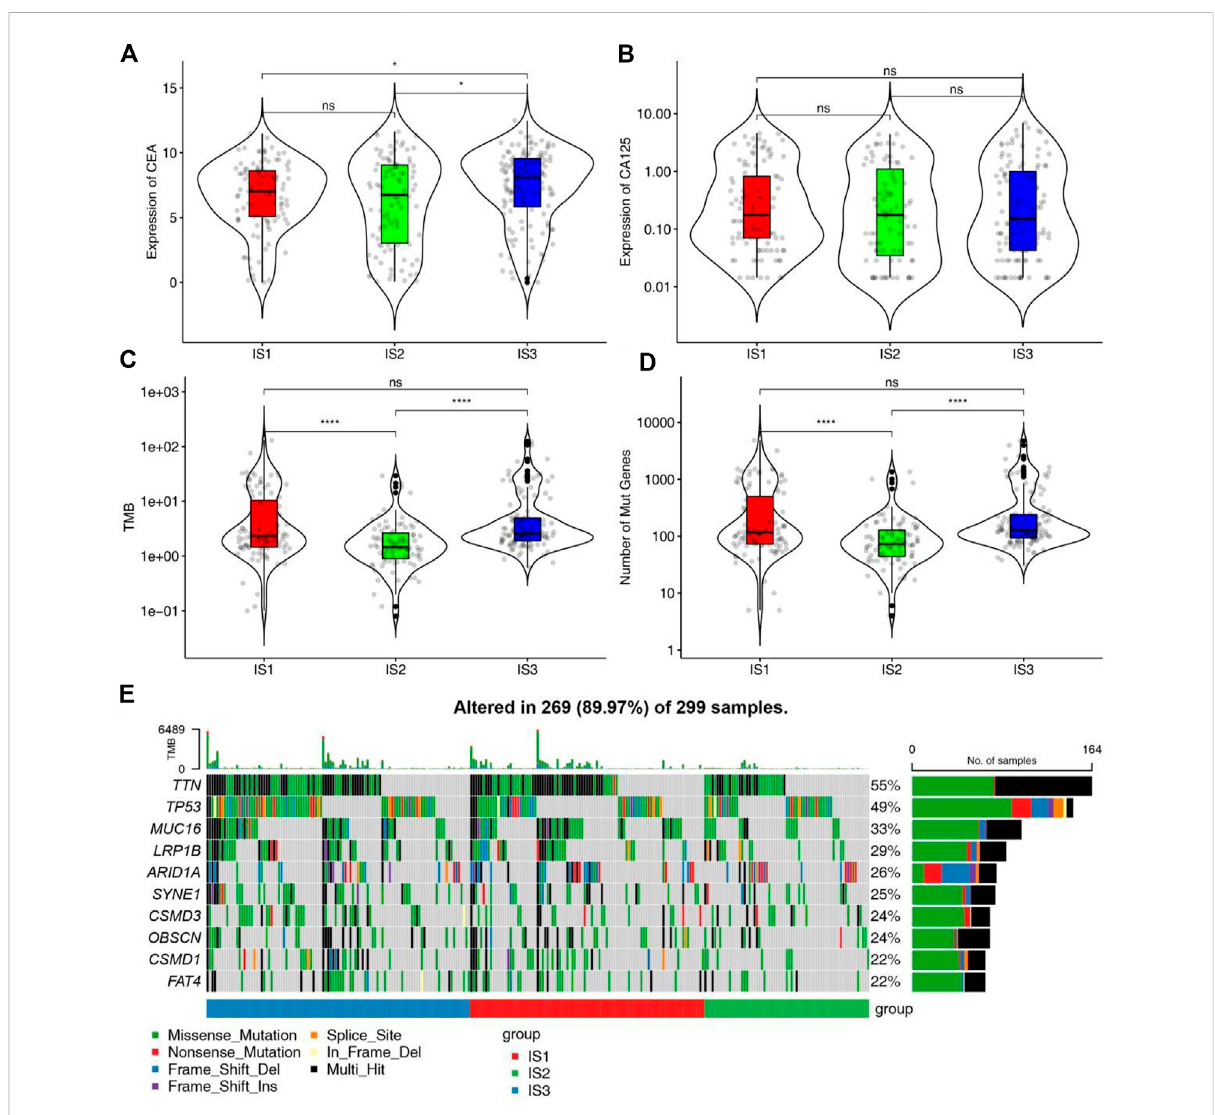
FIGURE 3 Associationbetweenmutationstatusanddifferentimmunesubtypes. (A,B) Associationbetweenimmunesubtypesand (A) CEAand (B) CA125in STAD IS1-IS3. (C,D) Association between immune subtypes and (C) TMB and (D) mutation number in STAD IS1-IS3. (E) Ten highly mutated genes in STAD immune subtypes. * p < 0.05 and **** p < 0.0001.